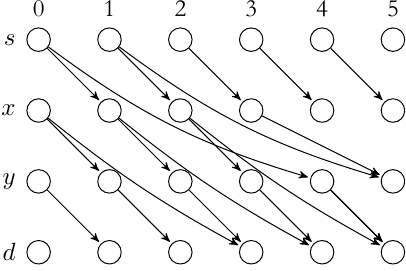
Figure 2: Time expanded network with cost as travel time on